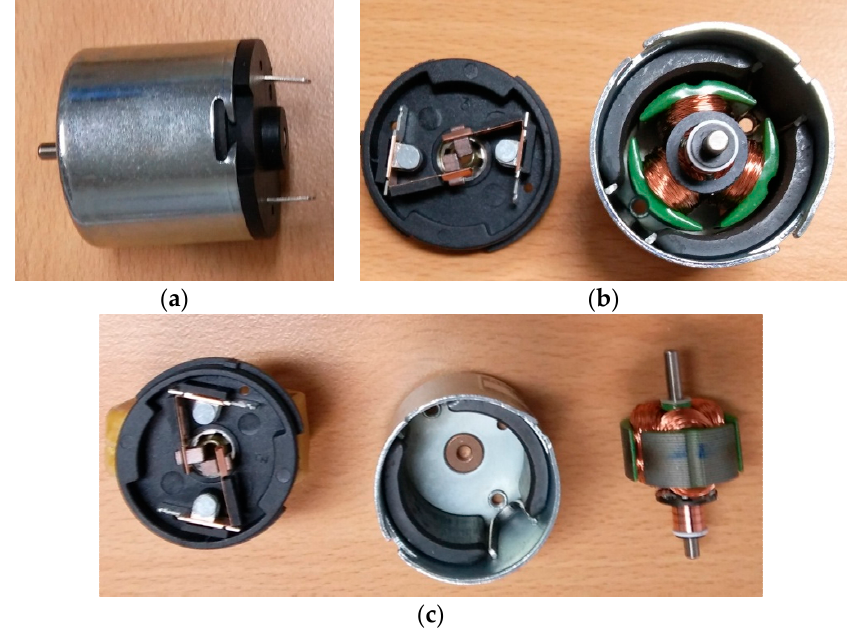
Figure 1. The exterior and interior of a small direct current (DC) motor with brushes used for noise measurement: ( a ) small DC motor exterior; ( b ) three-pole rotor installed inside the motor housing with two permanent magnets and the brush cap open; ( c ) three-pole rotor with grooved armature separated from the motor housing.